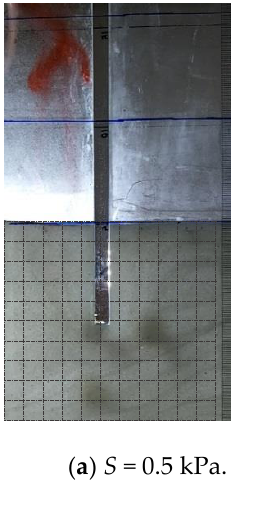
Figure 8. The soil plug in the caisson.